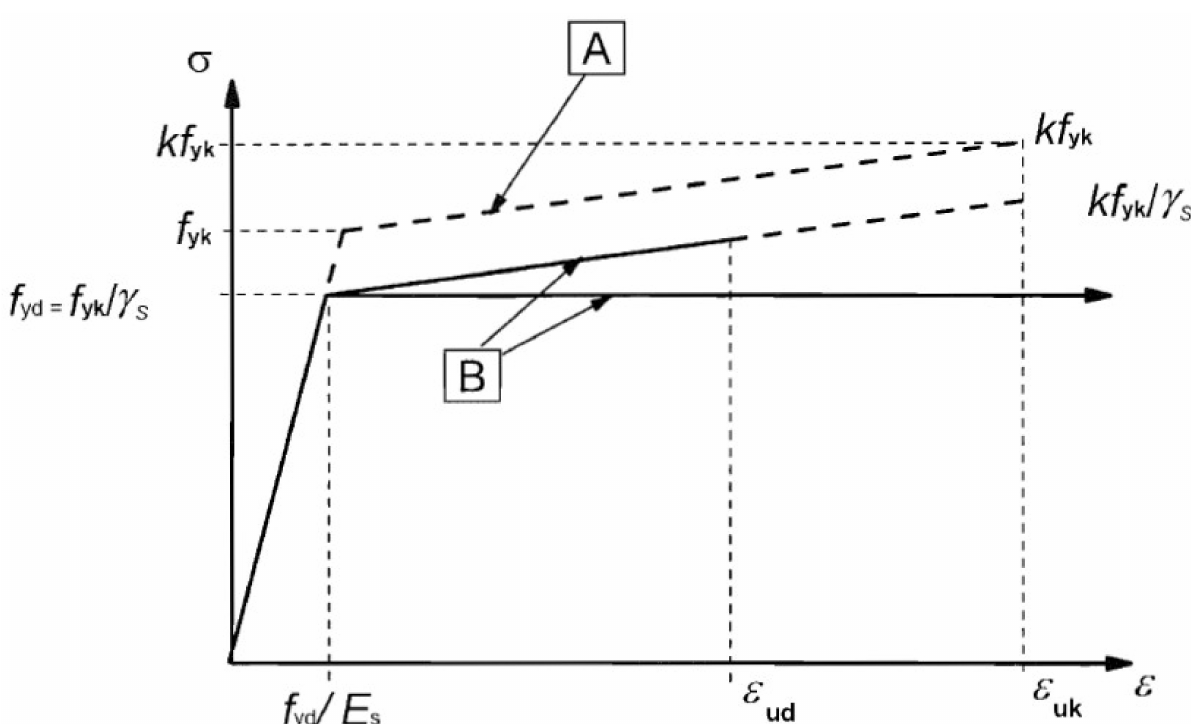
Figure 12. Stress–strain relation for